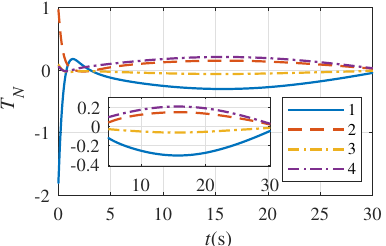
Figure 5. Control torque of joints.